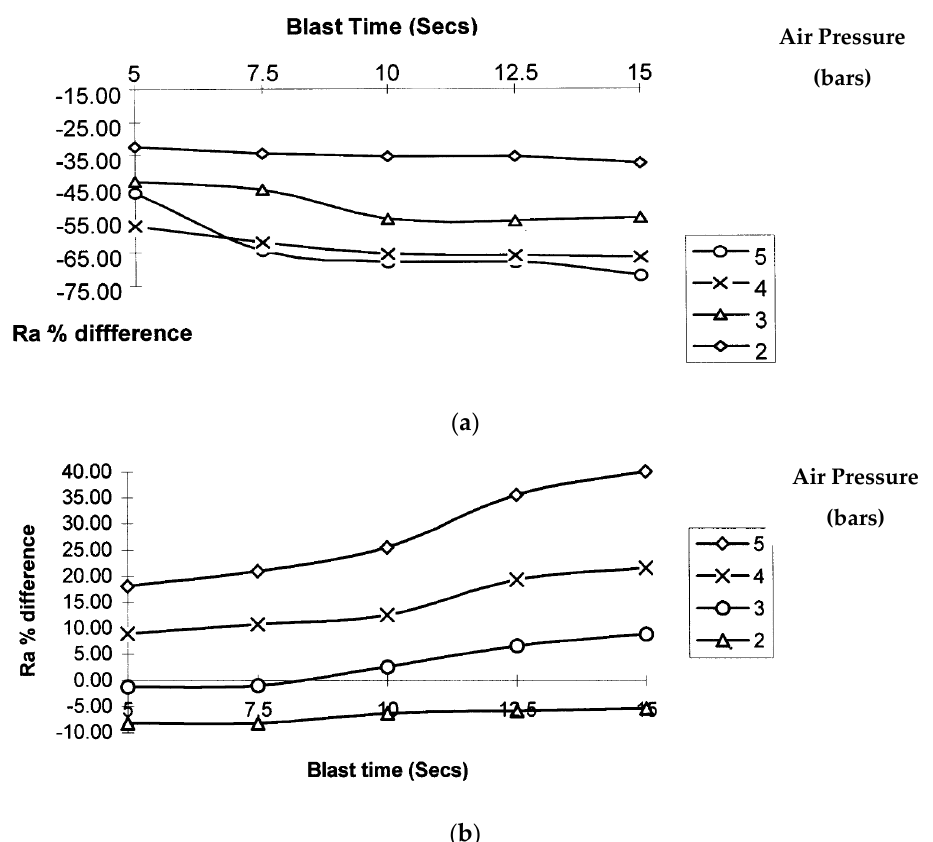
Figure 2. Surface roughness variation with respect to process parameters for: ( a ) aluminum oxide ( b ) and glass bead abrasives [13].